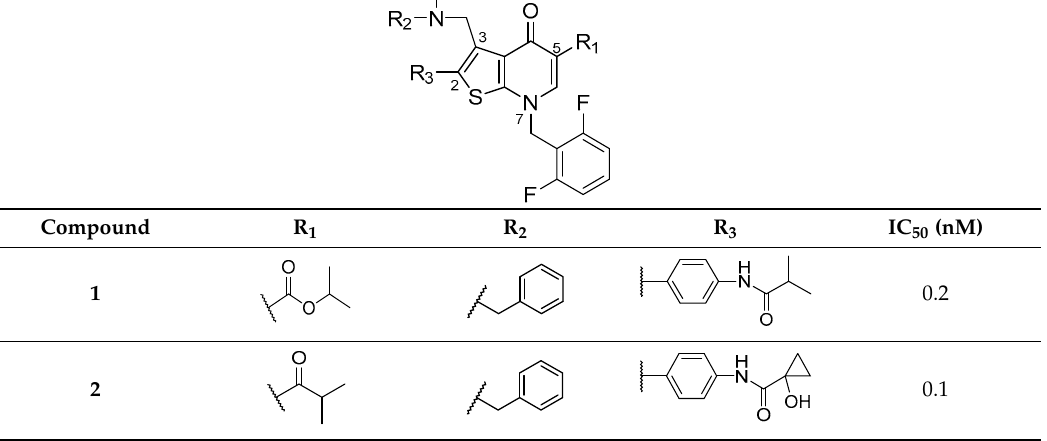
Table 2. Thieno[2,3- d ]pyrimidine-2,4-one derivatives and their binding affinity at human GnRH.